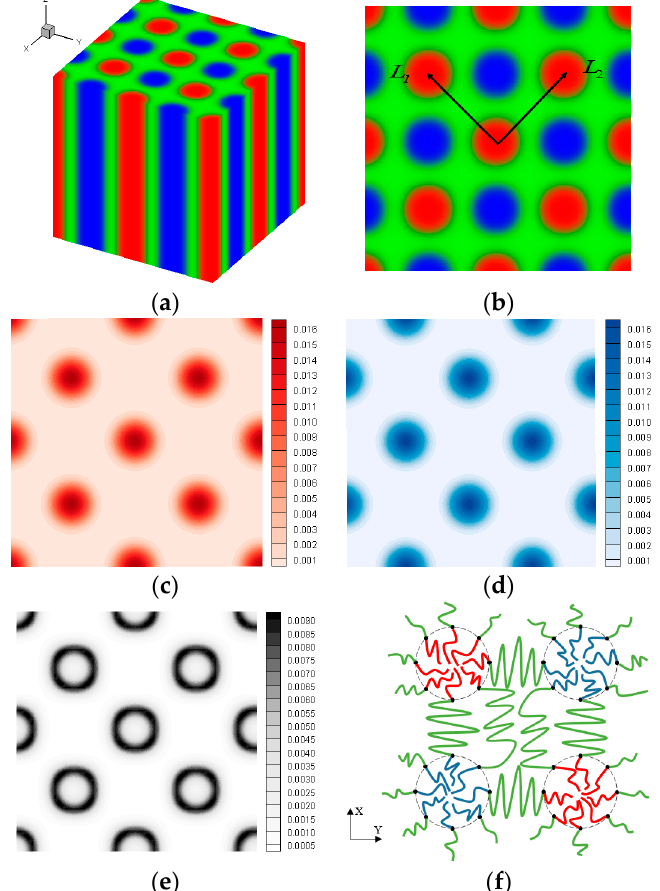
Figure 2. Representative bulk morphology of linear triblock copolymers at χ ij N = 35 and f A : f B : f C = 0.2:0.6:0.2. Plots ( a , b ) illustrate the 3D two-colour column (TCC) structure and the volume fractions of the system on a plane perpendicular to the columnar axis, where red, green and blue represent A-, B- and C-rich domains, respectively. Density plots for the A-terminal, C-terminal and AB conjunction points on the same plane are depicted in ( c – e ), correspondingly. The schematic for a TCC cylinder region is demonstrated in ( f ), in which the grey dashed lines represent the domain interfaces.